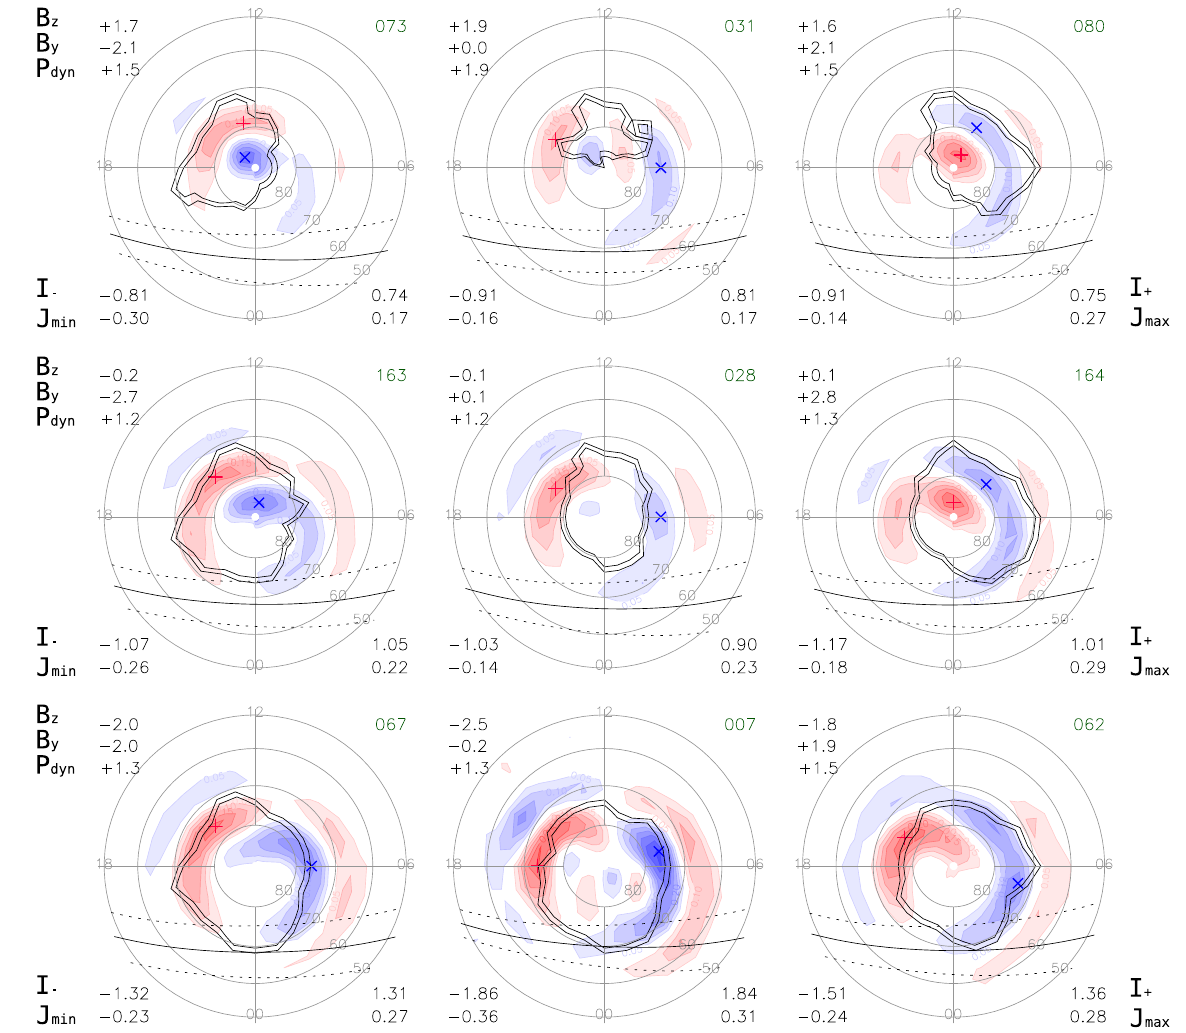
Fig. 4. Northern Hemisphere summer average field-aligned current distributions for | B IMF |≤ 4. Each panel shows the average of the number of events indicated at the top right (e.g. 73 for the top left panel). The mean IMF B z and B y (nT) and P dyn for these events are shown at the top left for each panel. The location of the maximum and minimum current densities are indicated by the “+” and “x” symbols respectively. The current density values (J; µAm − 2 ) at these locations are the lower numbers at the bottom left (minimum) and bottom right (maximum). Total upward and downward current (I; MA) are shown just above the current density values. Red indicates upward current and blue is downward current. Contour levels are in 0.05 µAm − 2 steps. The approximate open-closed field line boundary calculated from the Tsyganenko and Sitnov (2005) field model for the mean IMF parameters is shown by the two black traces around the pole. All panels include the 1 standard deviation range in the location of the sunlit terminator. Coordinates are geomagnetic latitude and magnetic local time